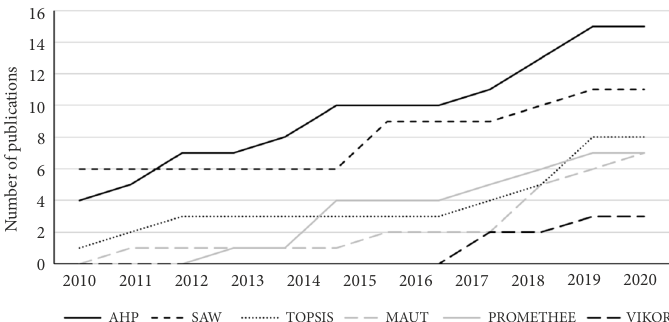
Figure 9. Distribution over time of the main MCDM techniques used in sustainable bridge designs